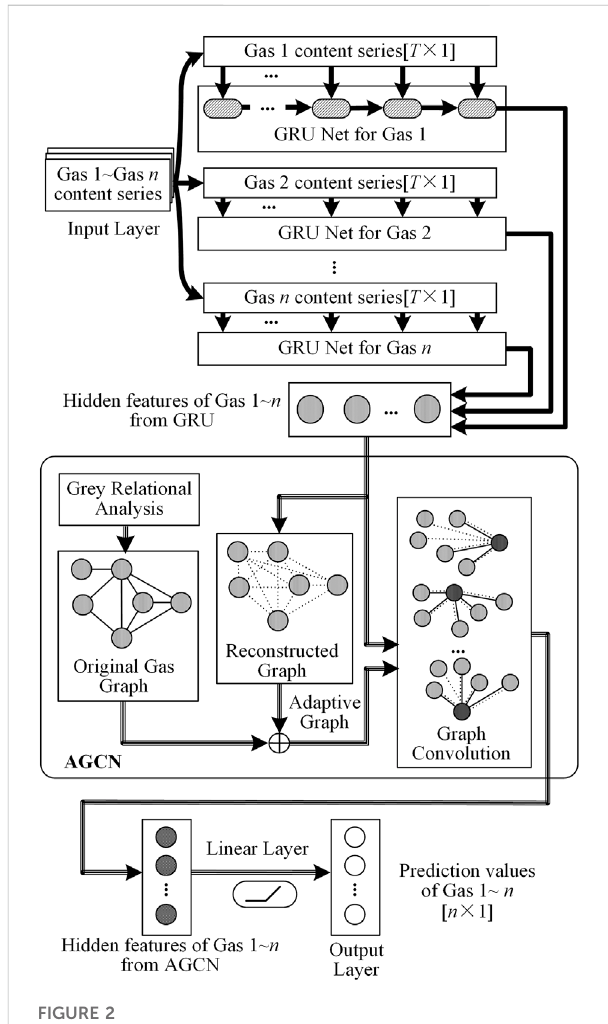
FIGURE 2 Structure of GRU-AGCN model for gas content